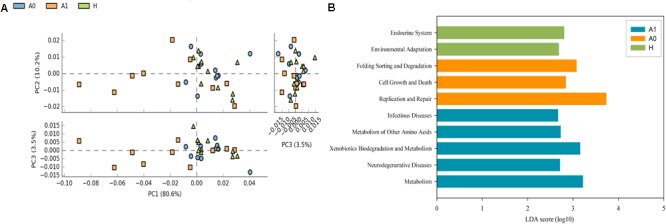
Functional and metabolic discrepancy of the gut microbiota between CRC patients and healthy individuals. (A) Principal component analysis (PCA) plot of the KEGG pathway (L2) shows that the post-surgery CRC patients were noticeably different from the pre-surgery CRC patients and healthy individuals based on the STAMP analysis. Characteristics with an LDA score cut-off of 2.0 were considered as being different. The LDA scores (log10) > 2 are listed; (B) Discriminatory functional pathways (KEGG L2) shows the significantly different between CRC patients and healthy individuals based on the LDA score using the LEfSe analysis.